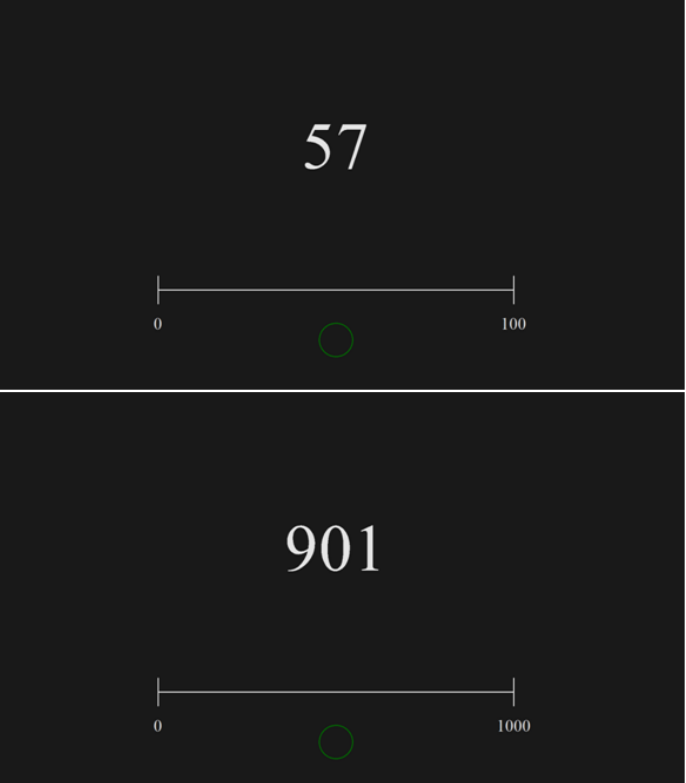
Figure 2. Examples of stimuli used in the number-to-position tasks that required estimating the location of the given number by pressing an estimated place on the screen, with the use of two numerical intervals: 0 – 100 ( top ) and 0 – 1000 ( bottom ).